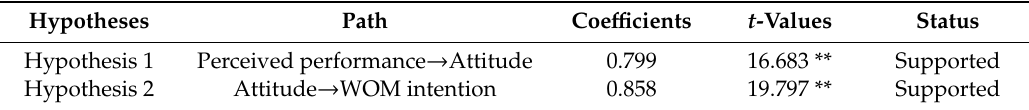
Table 3. Result of the structural model evaluation.